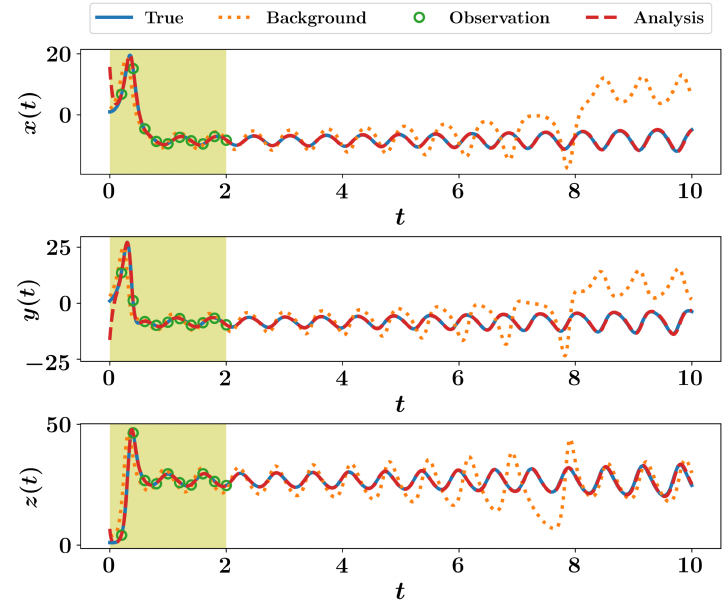
Figure 3. Results of FSM implementation for the Lorenz 63